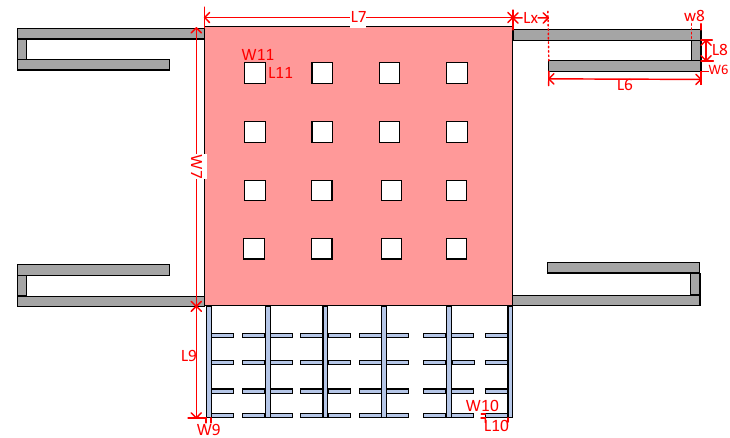
Figure 5. Finite element simulation of sensing structure.